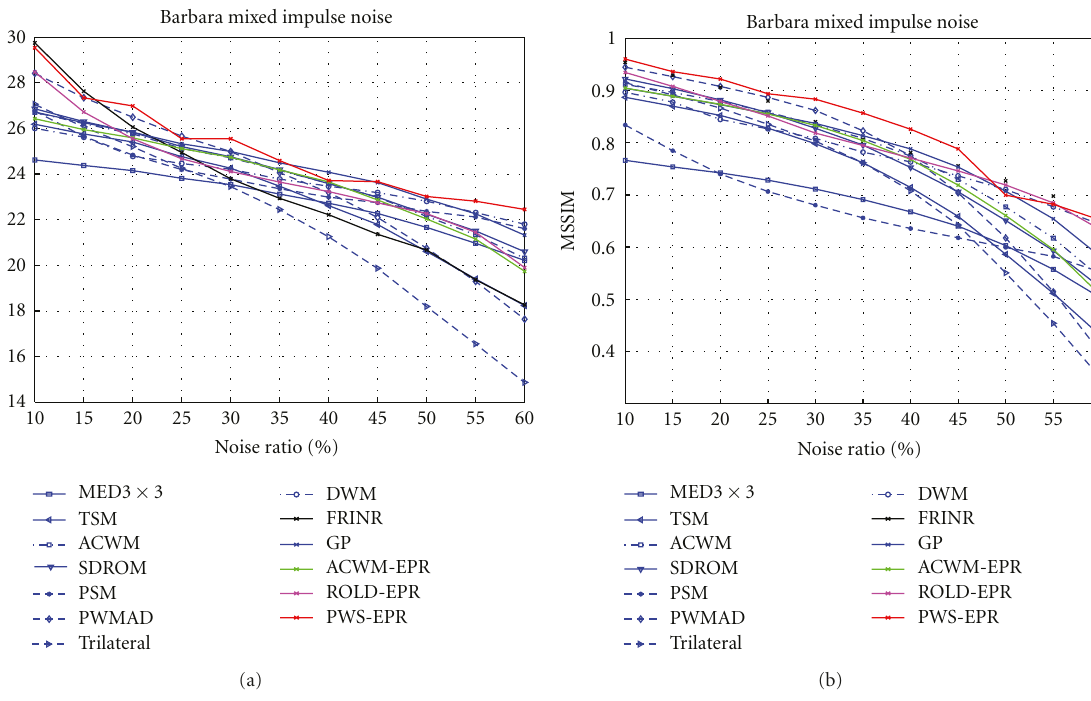
Figure 6: Peak signal-to-noise ratio (PSNR) and mean structure similarity index (MSSIM) obtained as a result of filtering the image Barbara corrupted by the mixed impulse noise whose ratio is spanning from 10% to